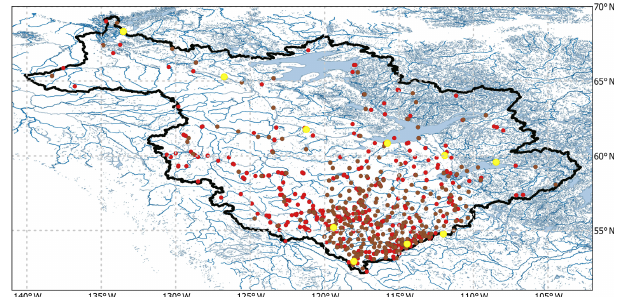
Figure 2. Spatial distribution of the initial 773 ground-based precipitation gauges (all dots) over the study area. Only 364 of these have records during the period 2005–2016 (brown and yellow dots). Data screening for missing values (10% thresh- old concurrently applied for all variables) during the 2005–2016 period resulted in 10 of these stations (yellow dots) being re- tained for validation of gridded datasets. Blue lines indicate river network sourced from: https://open.canada.ca/data/en/dataset/ 16e8a362-d8be-53b7-acb8-e3f9c5cd54ef (last access: December 2019).